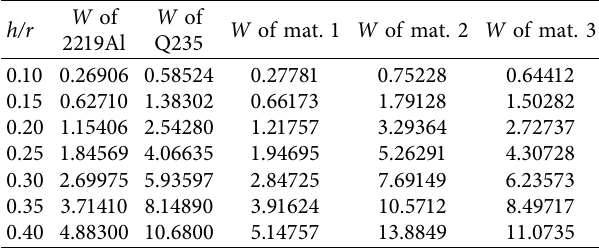
Table 3: W (N · mm) of 2219Al, Q235 steel, and the 3